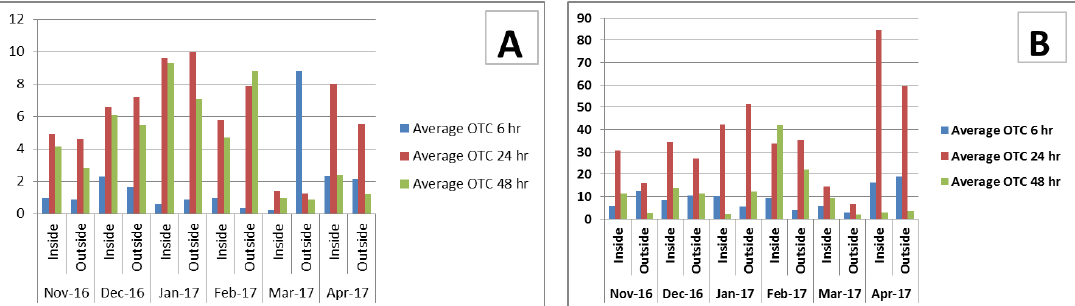
Figure 3: Average of Calculated Colony Forming Unit (A) Calculated of Colony Forming Unit for dilution 1 X 10 11 and (B) Calculated of Colony Forming Unit for dilution 1 X 10 12 . All Y-axis refer to Colony Forming